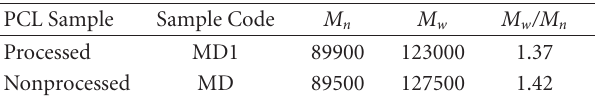
Table 3: Molecular weight distribution of processed and nonpro- cessed PCL.